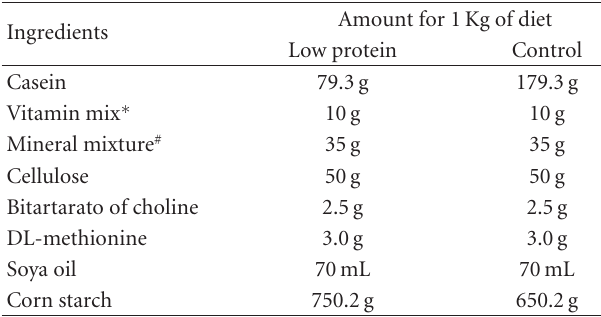
Table 1: Composition of the diets (control 17% and low protein